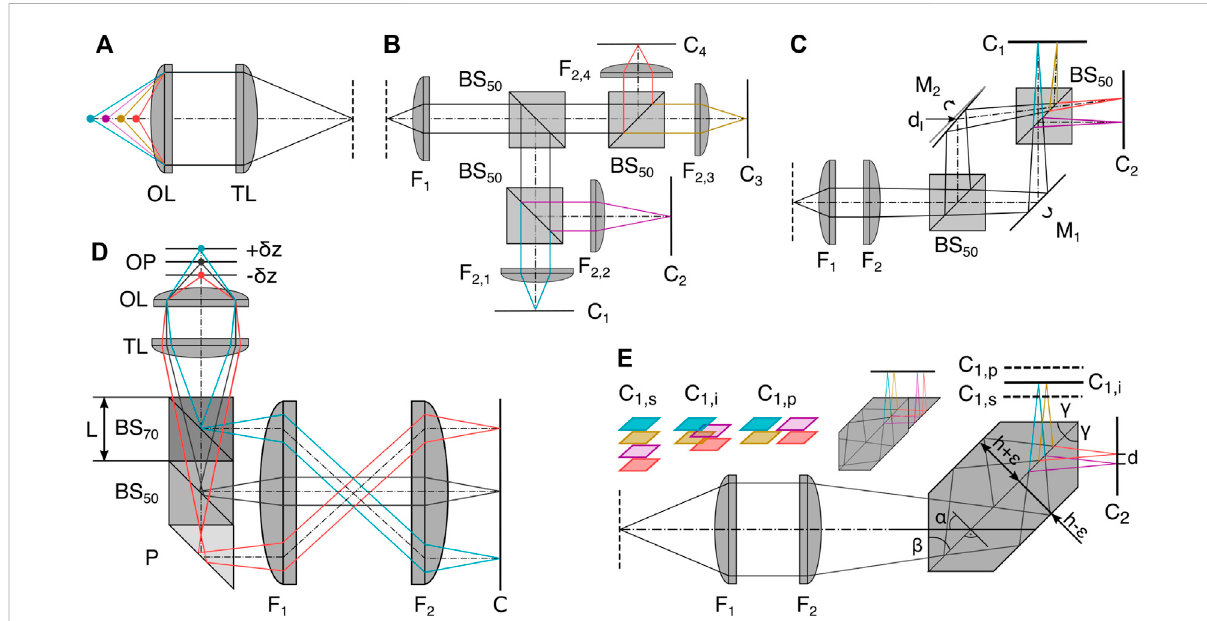
FIGURE 3 Refractive imagesplitting. (A) De fi nitionofaxialpositionwith respect totheobjective lensOLandtubelens TL. (B) 50:50 beamsplitter BS 50 and different focal length lens implementations ( F 2, i [22]. (C) Beamsplitter BS 50 and mirror M i combination whereby M 2 is displaced horizontally by d and rotated out of the symmetric position. Dual camera C i positioning allows interleaved, sequential, or high-speed con fi guration depending on relative axialpositioning[23]. (D) Multiplaneimagesplitter consisting ofa30R:70T BScube,a50R:50T BScubeandaright-angle prism(P)all cemented together using optical adhesive [11]. (E) The single entity prism in the 2 × 2 con fi guration as a more robust iteration of (C) [10]. Axial displacement